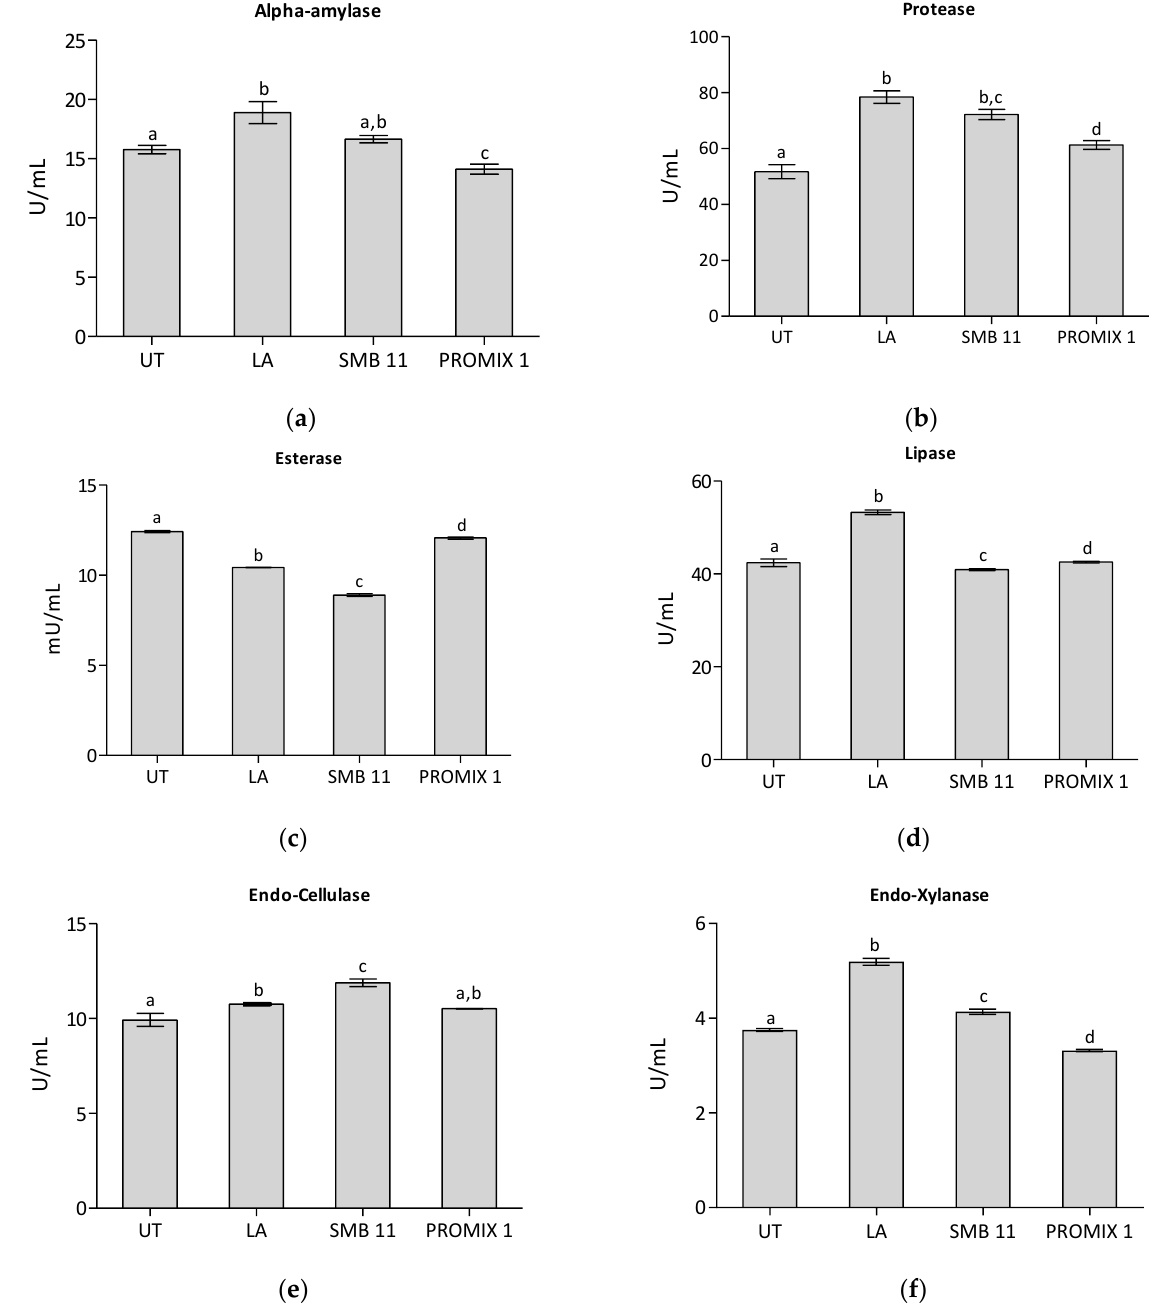
Figure 2. Enzyme activities in untreated control (UT) and in fermented seaweed. LA: Lactobacillus acidophilus SBM-11: a mix of Lactobacillus sakei , Staphylococcus carnosus and Staphylococcus xylosus ; PROMIX 1: Staphylococcus xylosus . Data were submitted to one-way analysis of variance (ANOVA), Tukey’s post hoc method was applied to establish significant differences among samples ( p < 0.05).